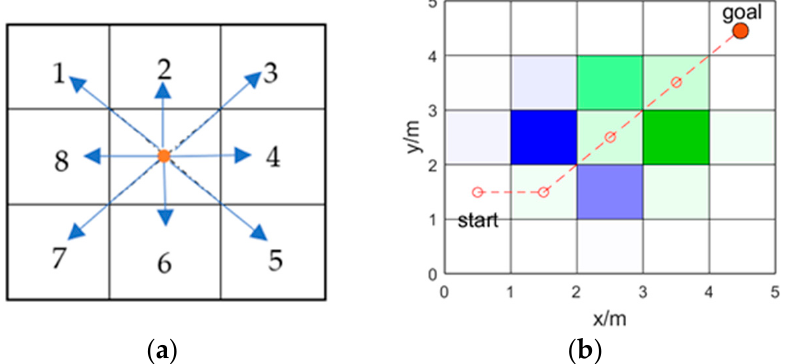
Figure 2. ( a ) The moving direction of the robot; ( b ) The planned trajectory limited by the height threshold.